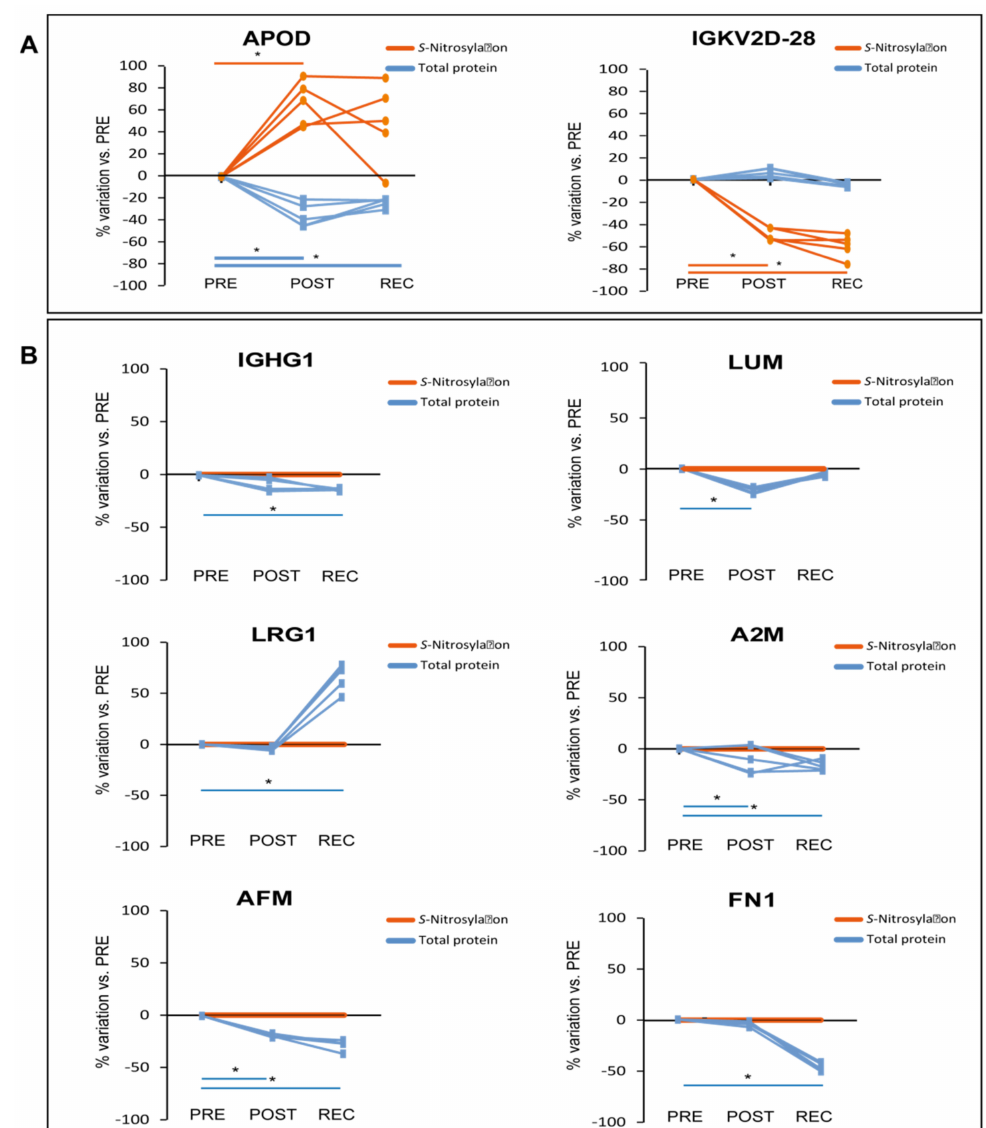
Figure 7. Results from iodoTMT LC-MS/MS proteomic analysis of placebo-treated subjects. Dif- ferentially abundant proteins from TMT and iodoTMT analyses are expressed as a percentage of variation from PRE. Blue lines refer to total protein, while orange lines to protein S -Nitrosylation. Significant alterations in protein S -nitrosylation ( A ) and significant alteration in total protein levels ( B ). Protein S -nitrosylation levels in ( B ) are normalized to 0% for graphical comparison. (One-way repeated measures ANOVA and Tukey’s test, n = 5, * p -value <